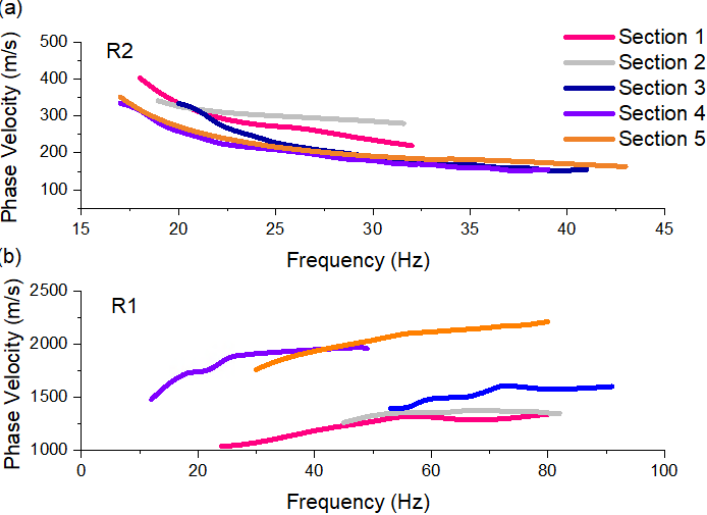
Figure B5. Summary of dispersion measurements for sections 1 to 5. (a) Dispersion curves of the R2 wave. (b) Dispersion curves of the R1